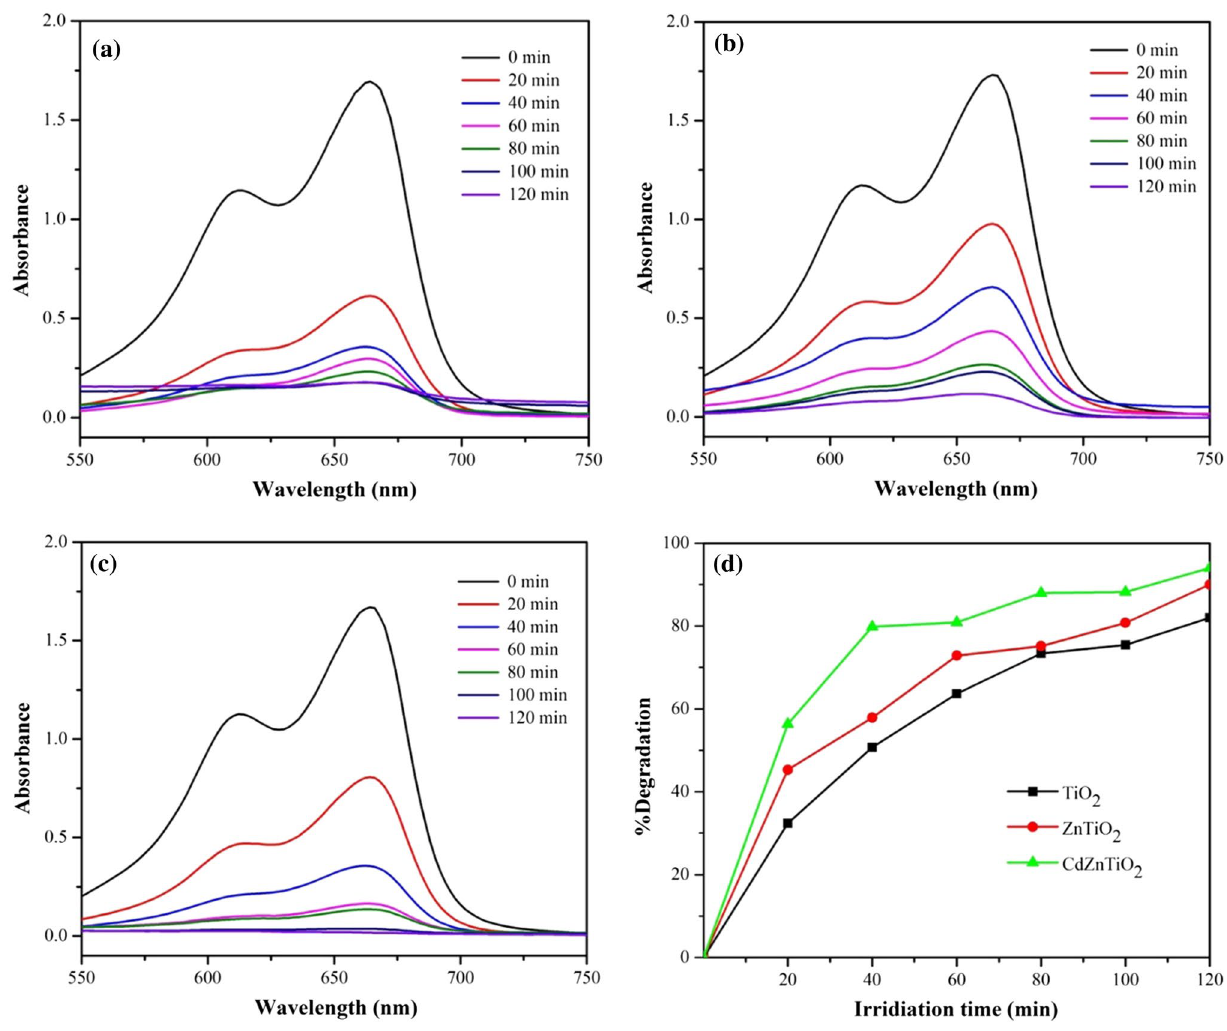
Fig. 7 a UV–visible absorption spectra of MB degraded by ( a ) TiO TiO 2 , ZnTiO 2 and CdZnTiO